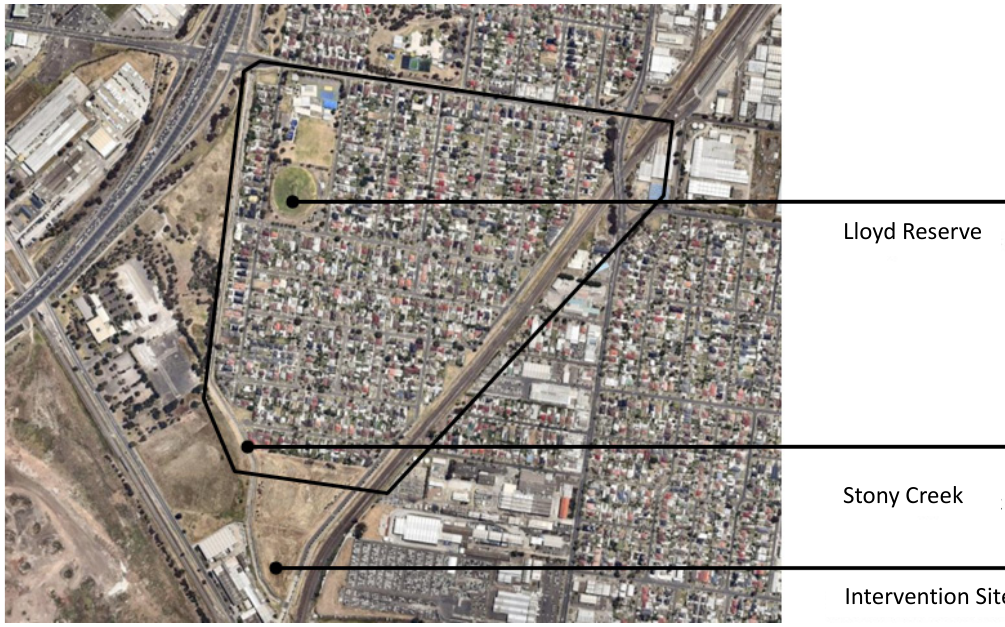
Figure 2: The area under study (Source: Nearmap)